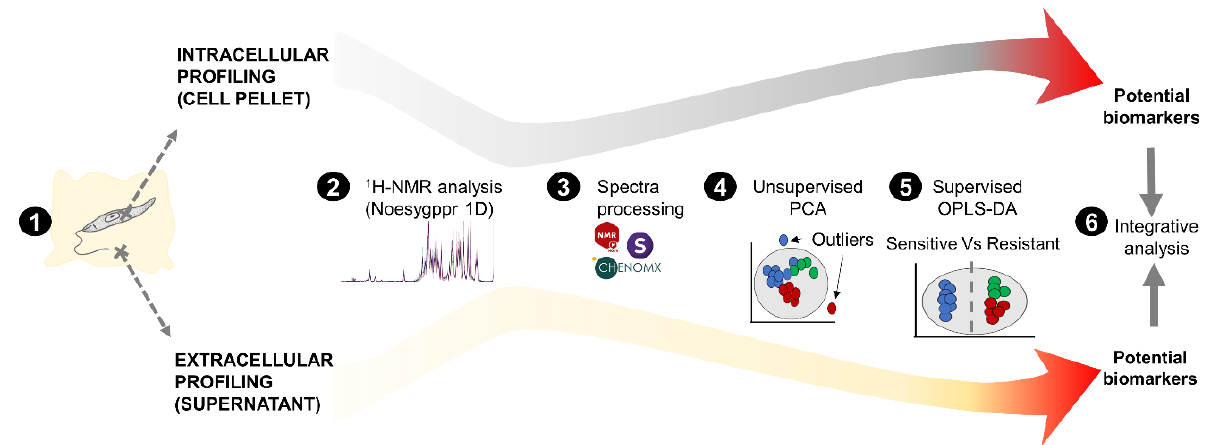
Figure 1. Experimental design to differentiate the metabolomic profiles in antimony-resistant and -sensitive L. tropica parasites. The workflow for intracellular and extracellular analysis is shown in parallel. (1) After parasite growth, the cell pellet and supernatant were collected and used for intracellular and extracellular analysis, respectively. (2) The methanol extracts were analyzed by 1 H-HMR using a Noesygppr1d pulse. (3) Spectra processing included the annotation, apodization, alignment, phasing, baseline correction, bucketing, data normalization, and data scaling, integrating the following software: Chenomx v8.5, MestReNova v14.2, and SIMCA Umetrics v14.1. (4) Unsupervised multivariate analysis by PCA for preliminary grouping visualization and outlier detection based on the Hotelling t-squared statistic with 95% confidence limit. (5) Supervised multivariate analysis by OPLS-DA for the identification of statistically significant “variable importance in projection” (VIP) or potential biomarker, filtering by the Jackknife method to correct estimation bias. (6) Finally, the VIPs were analyzed to discuss the possible biological